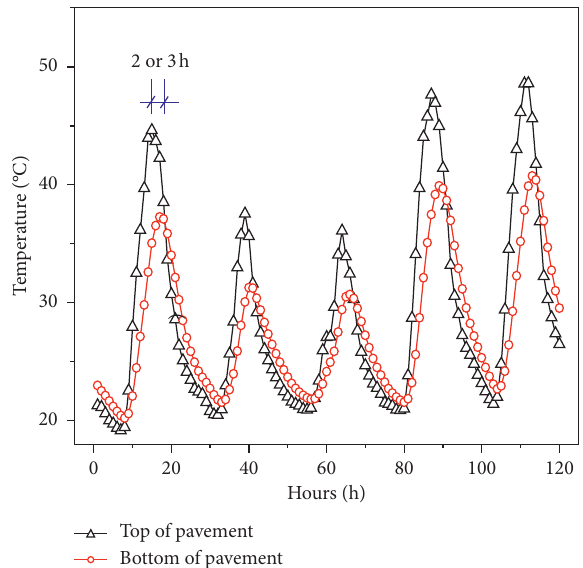
Figure 8: Comparison of variation of temperature between the top and bottom of pavement.